Question: What direction does the quantity move in — increasing or decreasing?
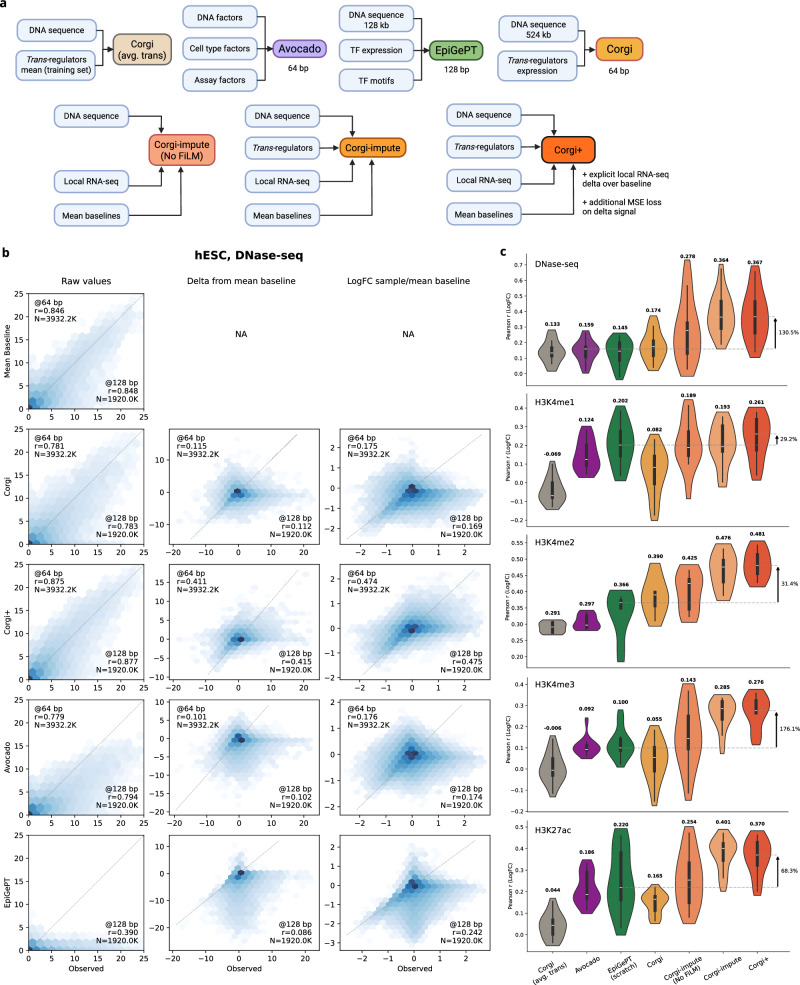
Answer: increasing